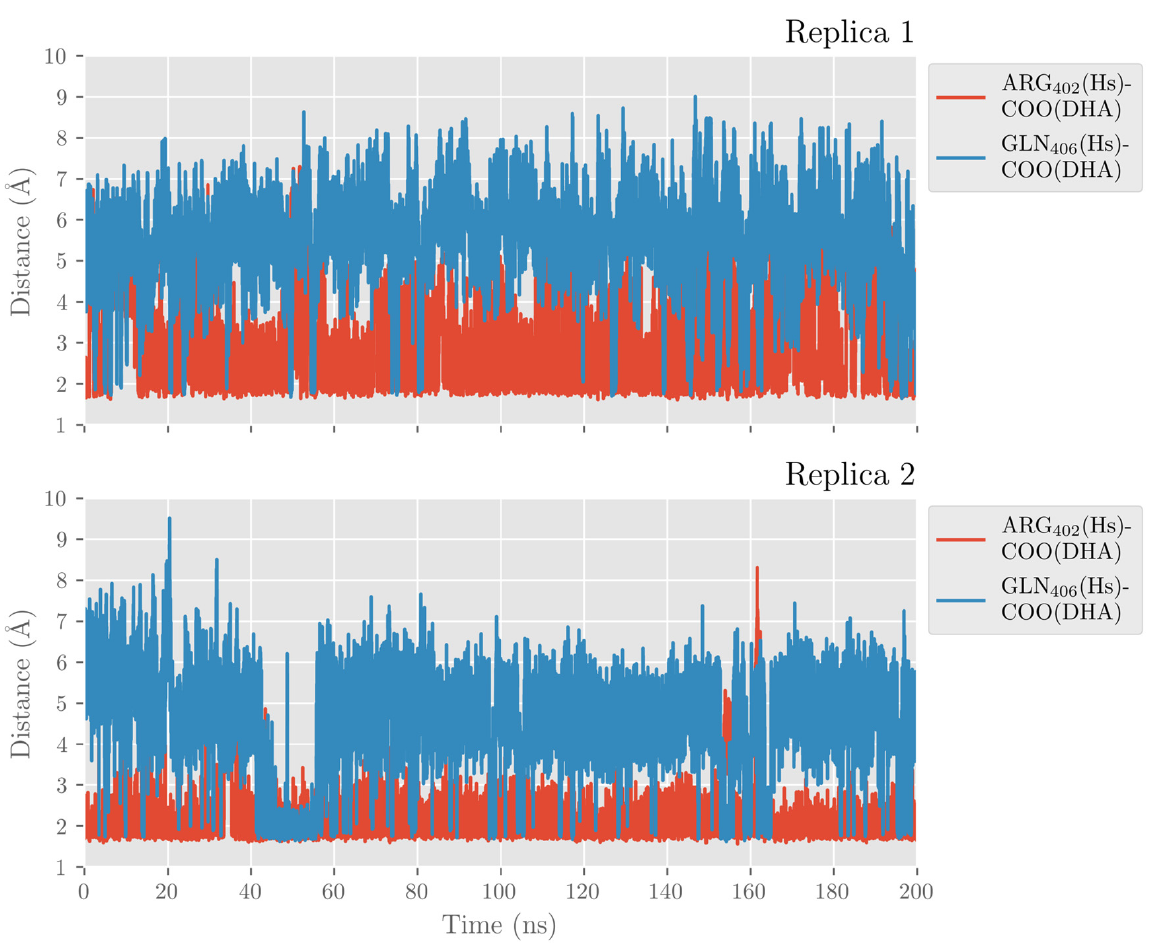
Figure 4. Distances of a carboxylate’s oxygen atom of DHA to the closest hydrogen atom in Arg402 and Gln406 versus time for the MD replica 1 and replica 2 in hALOX12.